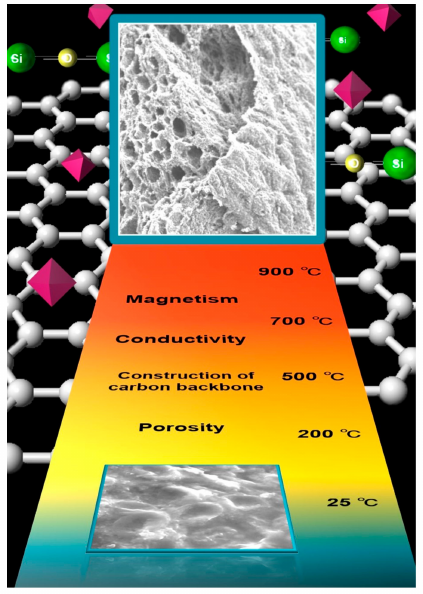
Figure 10. Formation of porous, conductive, and magnetic material by carbonization of the B. braunii residue flocculated with